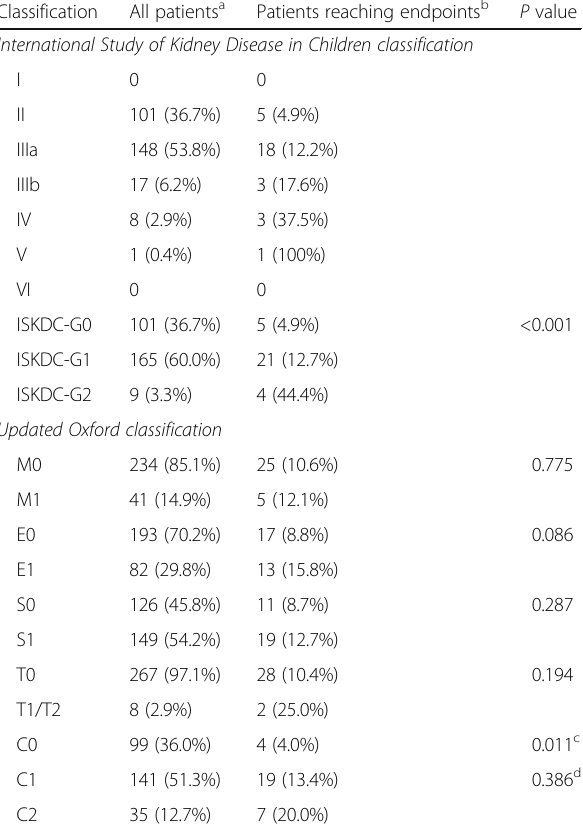
Table 3 Distribution of patients classified according to the updated Oxford classification or the International Study of Kidney Disease in Children classification Classification All patients a Patients reaching endpoints b P value International Study of Kidney Disease in Children